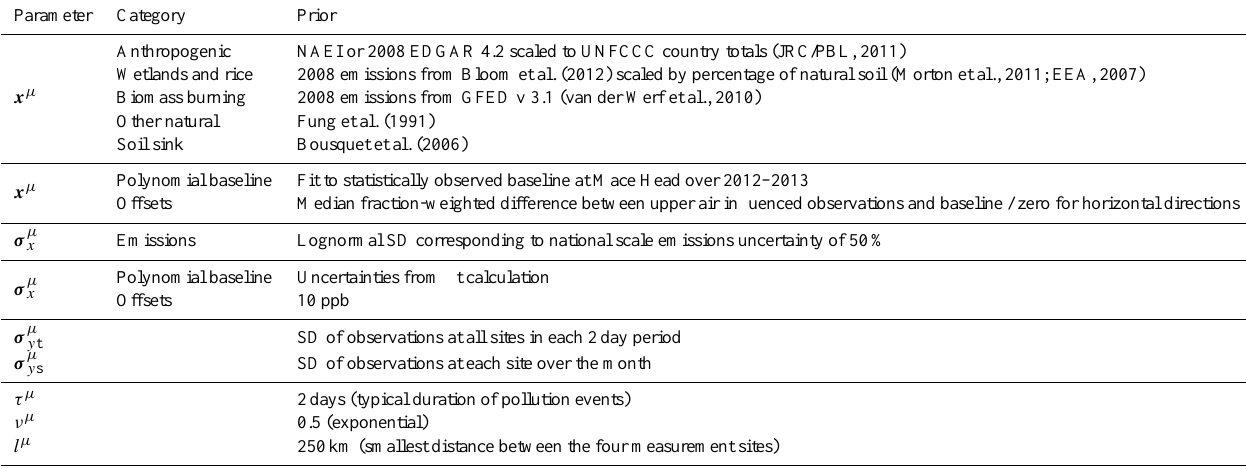
Figure 1. A priori emissions of CH 4 and N 2 O in log 10 (ggridcell − 1 s − 1 ). (Left) Major UK anthropogenic source sectors from the National Atmospheric Emissions Inventory. (Right) Annual average of total a priori emissions, including natural and anthropogenic sources for all countries. Colored circles show the measurement stations (MHD, yellow; RGL, magenta; TAC, cyan; TTA, green.) Table 1. Sources of a priori emissions used in the CH 4 study. Superscript µ denotes that these are the median values of the distribution.